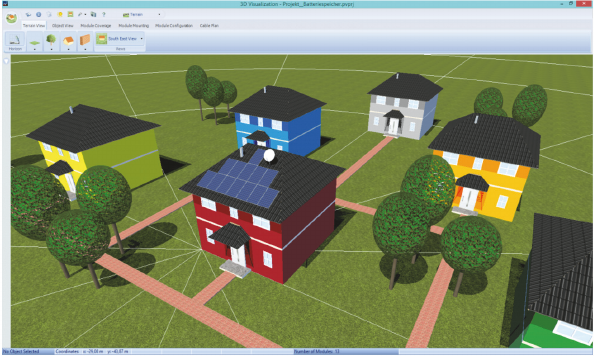
Figure 6: PV ∗ SOL 3D building modeling sample (source: http:// solarprofessional.com/articles/design-installation/performance-mod- eling-tools-overview/page/0/2).